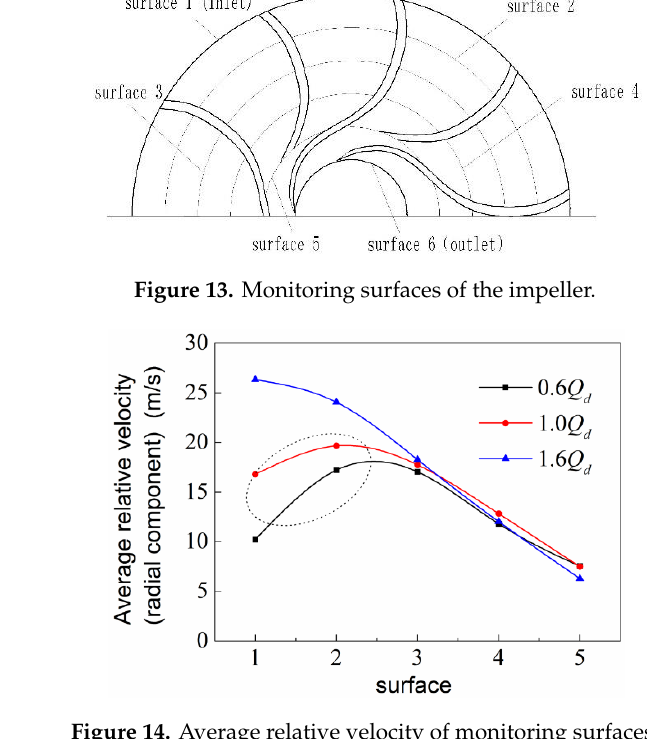
Figure 14. Average relative velocity of monitoring surfaces.